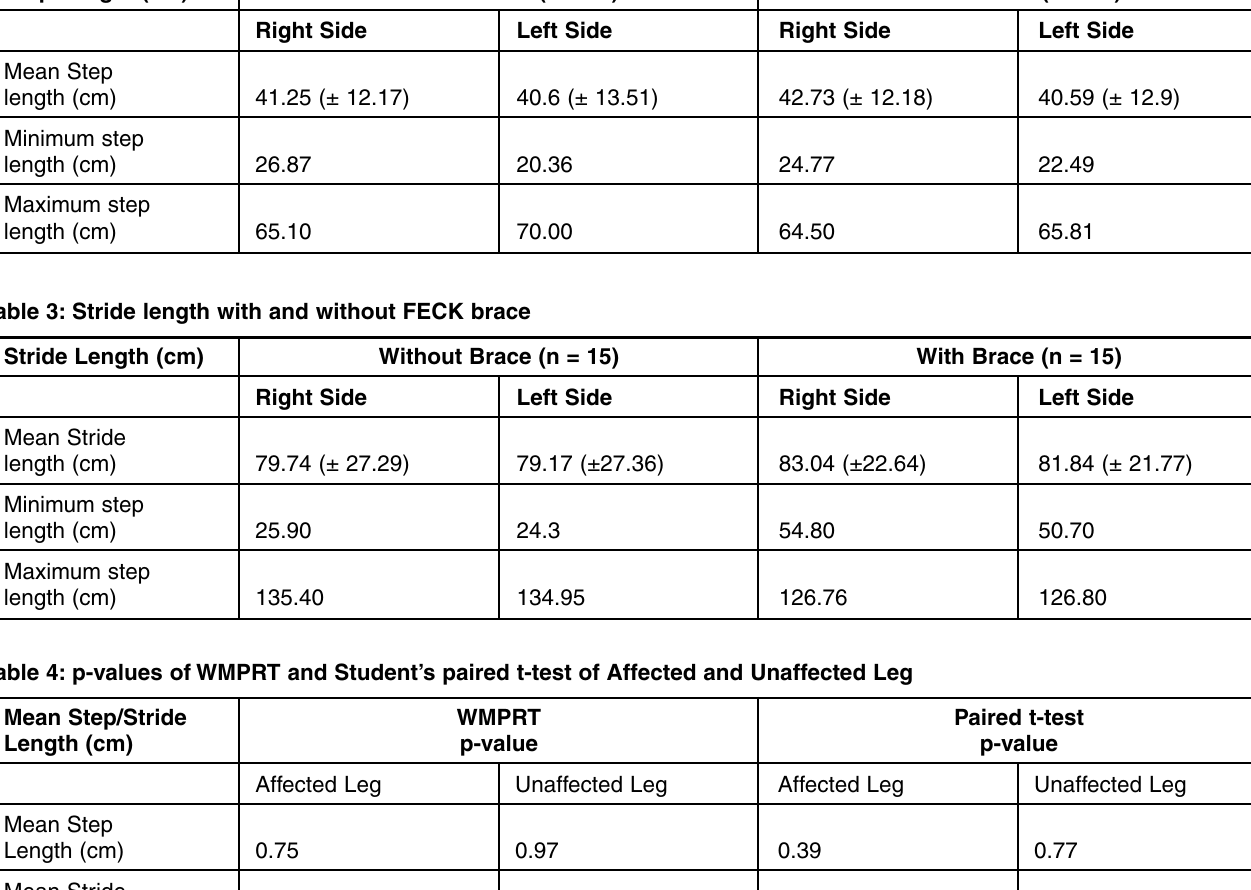
Table 1: Speed with and without FECK Brace. Speed (m/s)